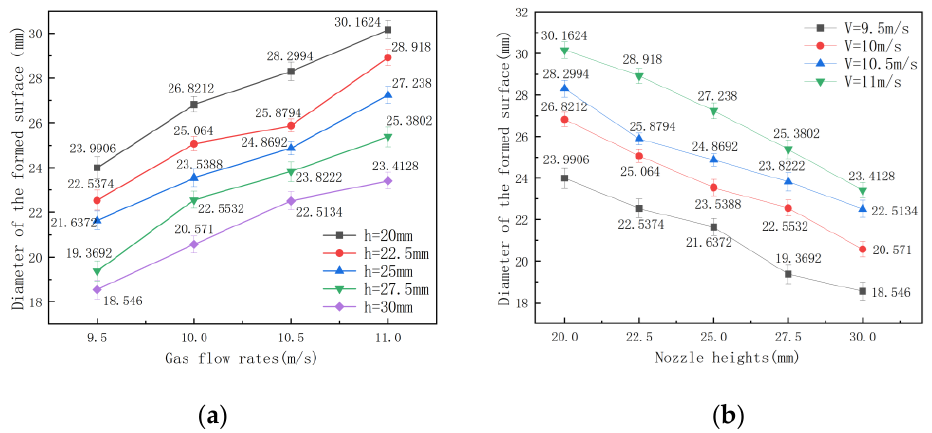
Figure 13. The diameter of the formed surface with different gas flow rates and nozzle heights in the experiments. ( a ) is the relationship between the gas flow rate and the diameter of the formed surface. ( b ) is the relationship between the nozzle height and the diameter of the formed surface.